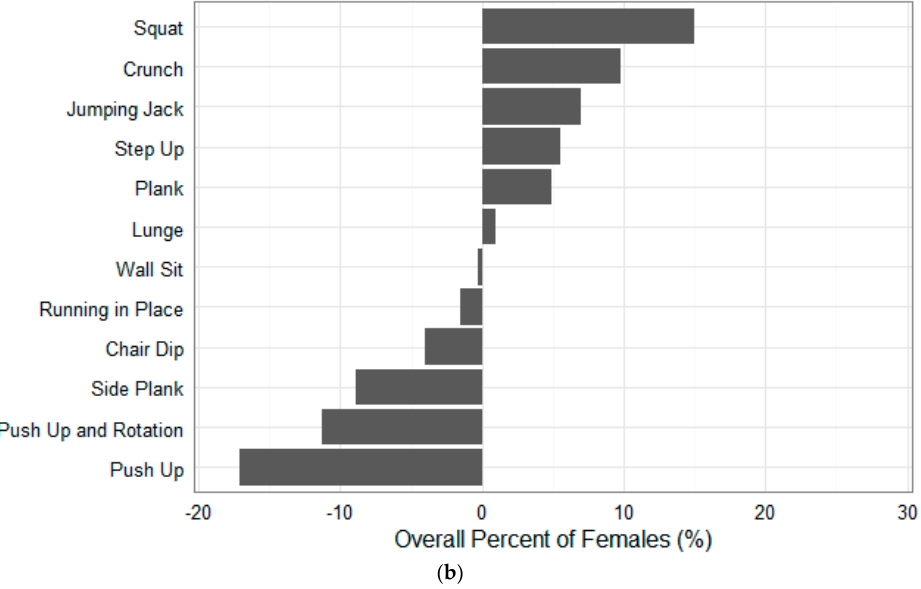
Figure 3. ( a ) Males’ exercise-types ranking profile based on overall preference percentage from Table 3. ( b ) Females’ exercise-types ranking profile based on overall preference percentage from Table 3.